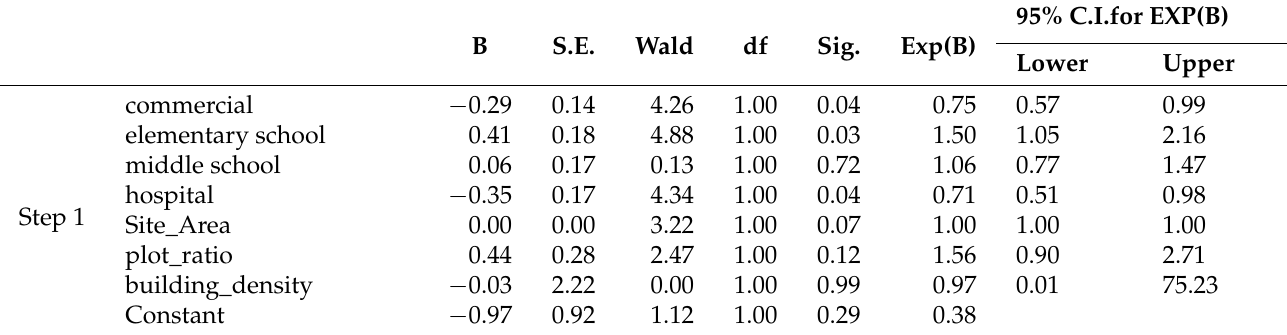
Table 6. Variables in the